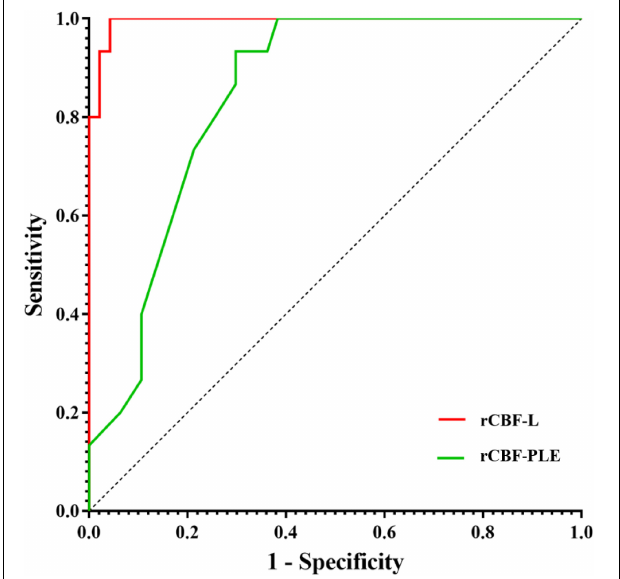
FIGURE 2 | Receiver operating characteristic curves for rCBF and rCBF-PLE for differentiating non-neoplastic from neoplastic lesions. AUC, area under the receiver operating characteristic curve; rCBF-L, relative cerebral blood flow of lesion; rCBF-PLE, relative cerebral blood flow of perilesional